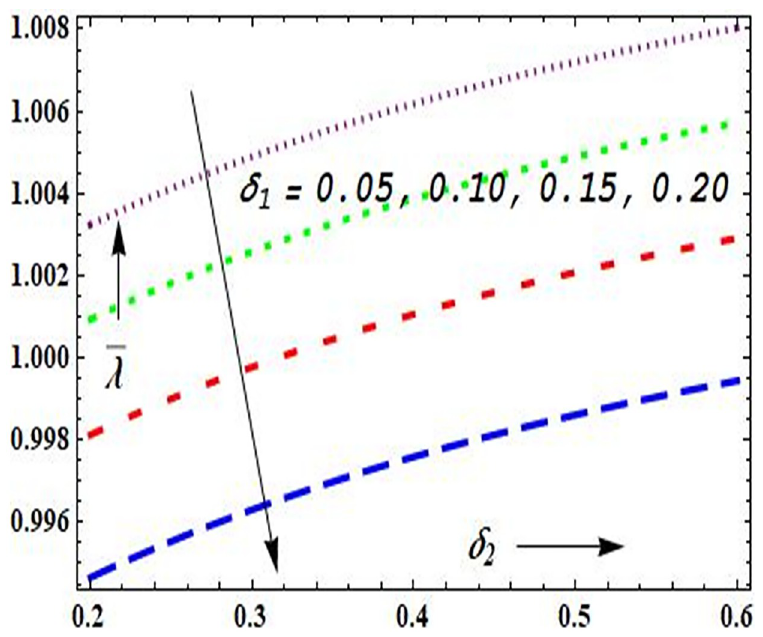
Fig 9. Plot of � λ on δ 2 and δ 1 with ϕ ¼ π